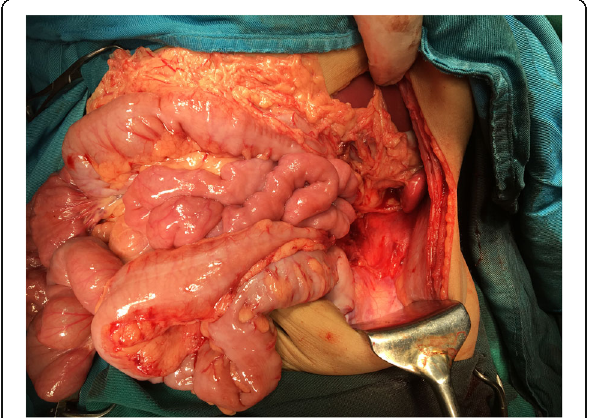
Fig. 3 Bloodless operative field after primary